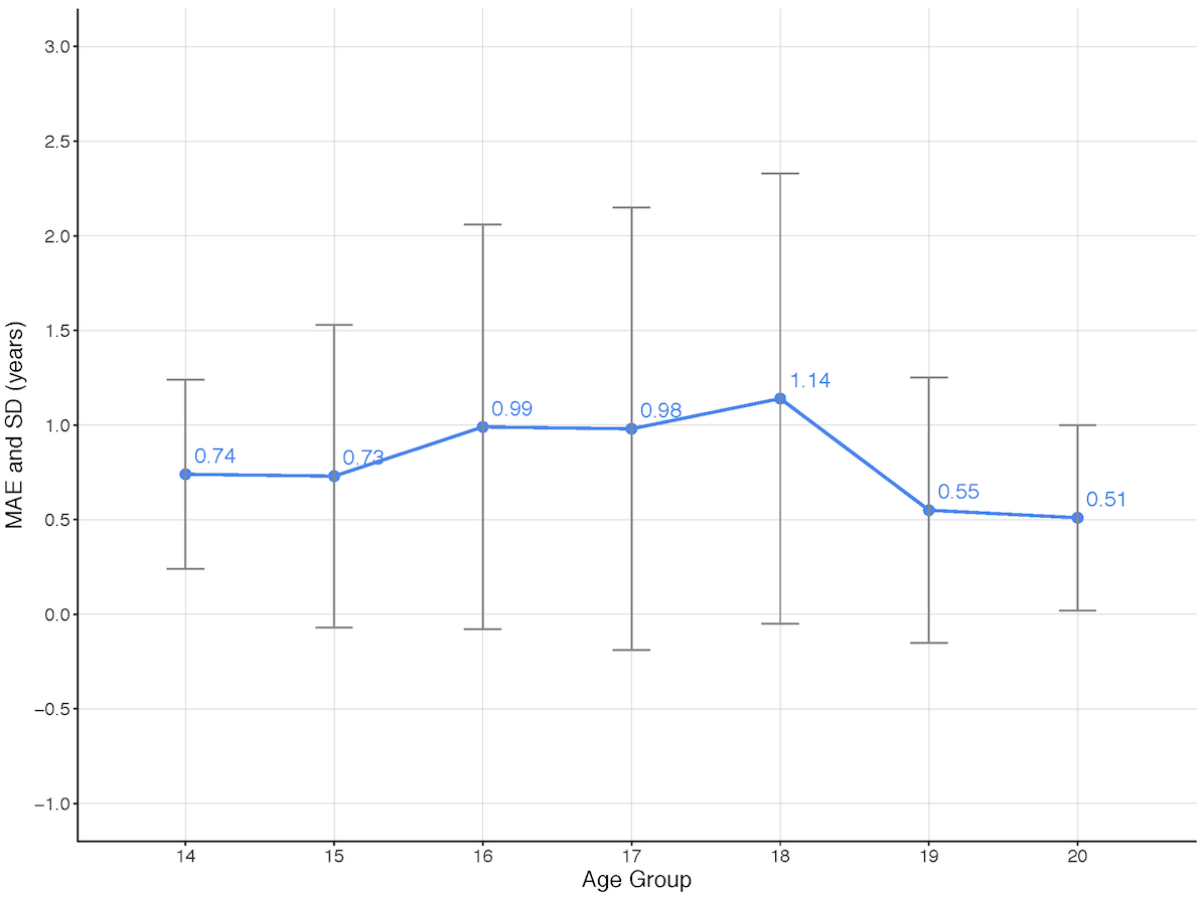
Figure 8. Mean absolute error (MAE) for the GoogLeNet model for male subjects in the applicable age